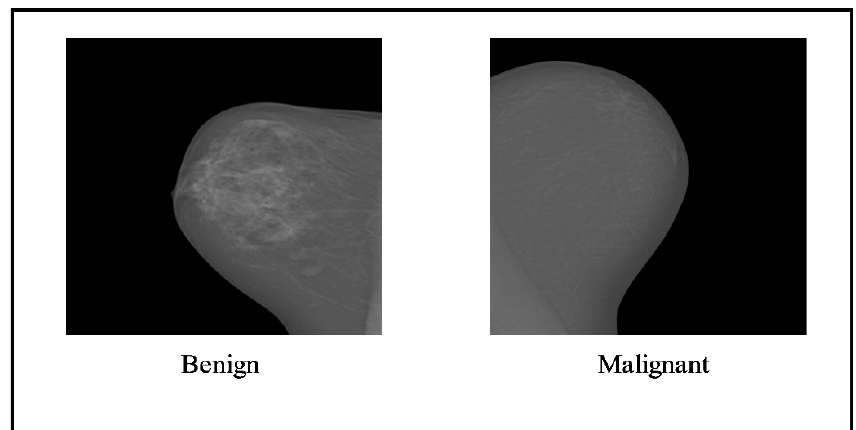
Figure 3. Sample images of the INbreast dataset [39] .